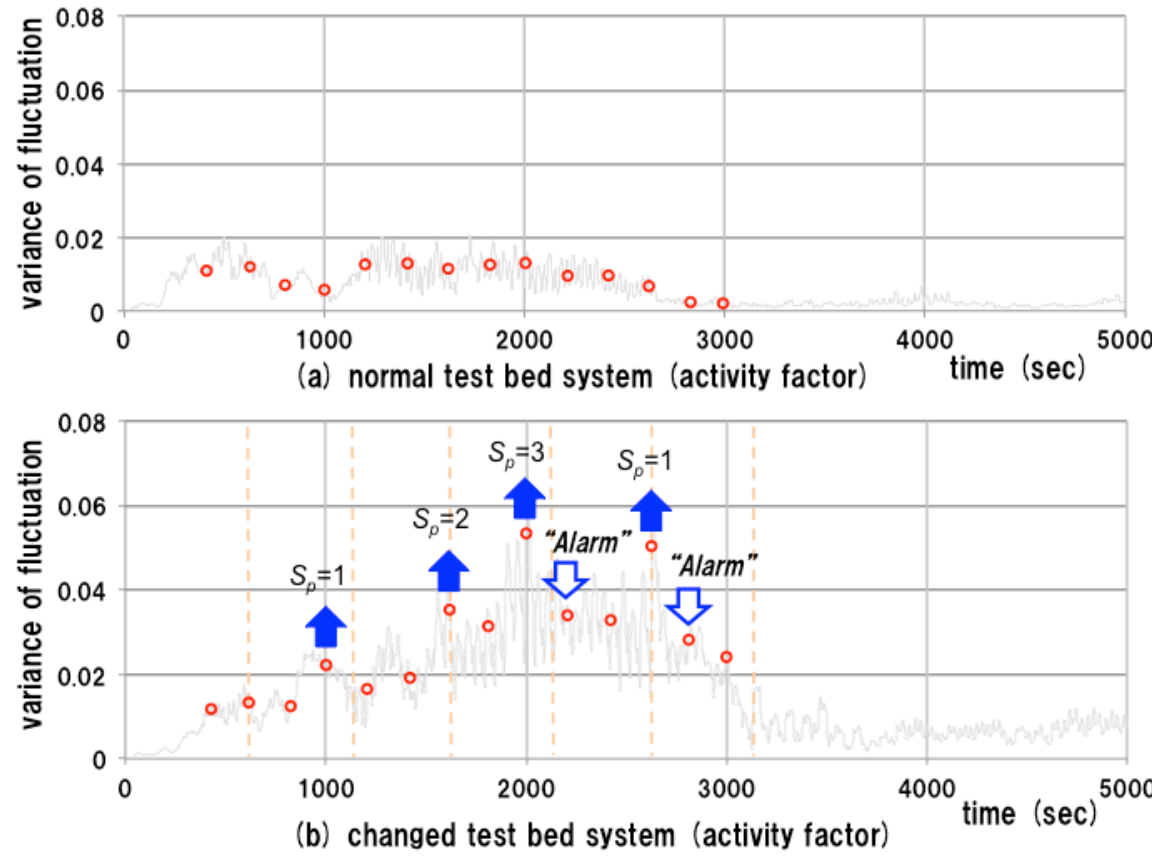
Figure 10. Experiment on an observation in on-line